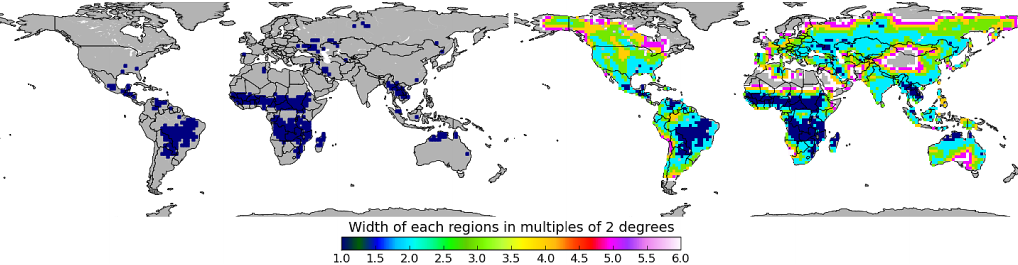
Figure 1. Width in multiples of 2 ◦ of every region with more than 400 positive 0.5 ◦ FRP grid cells from Terra and Aqua, in the period from 1 January 2003 to 31 December 2011. Fixed regions are on the left, and adaptive regionalization algorithm on the